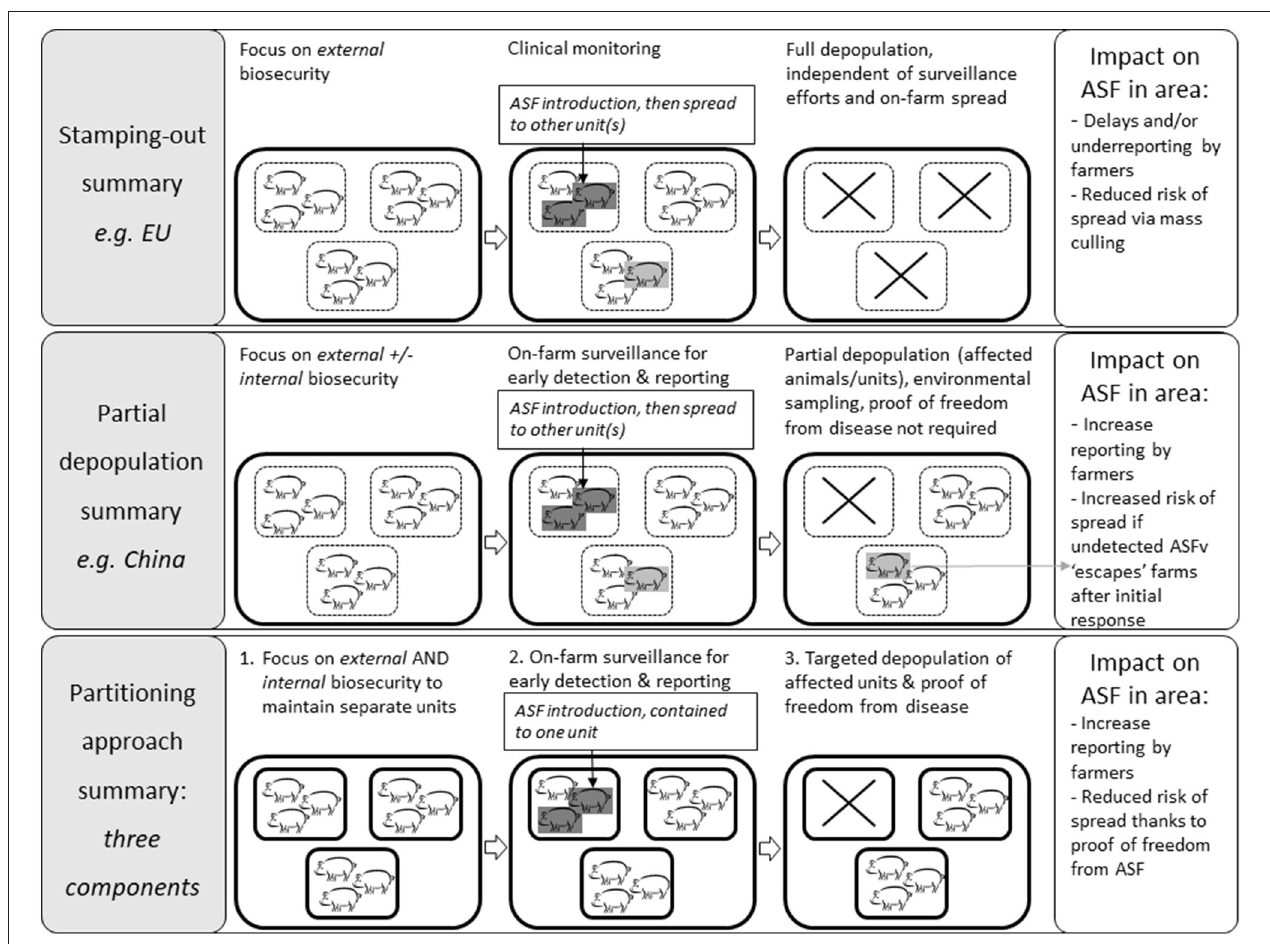
FIGURE 1 | Comparison of the principles of the standard ASF control approach, partial depopulation, and Partitioning approach, using an example farm with three epidemiological units (e.g., three finishing